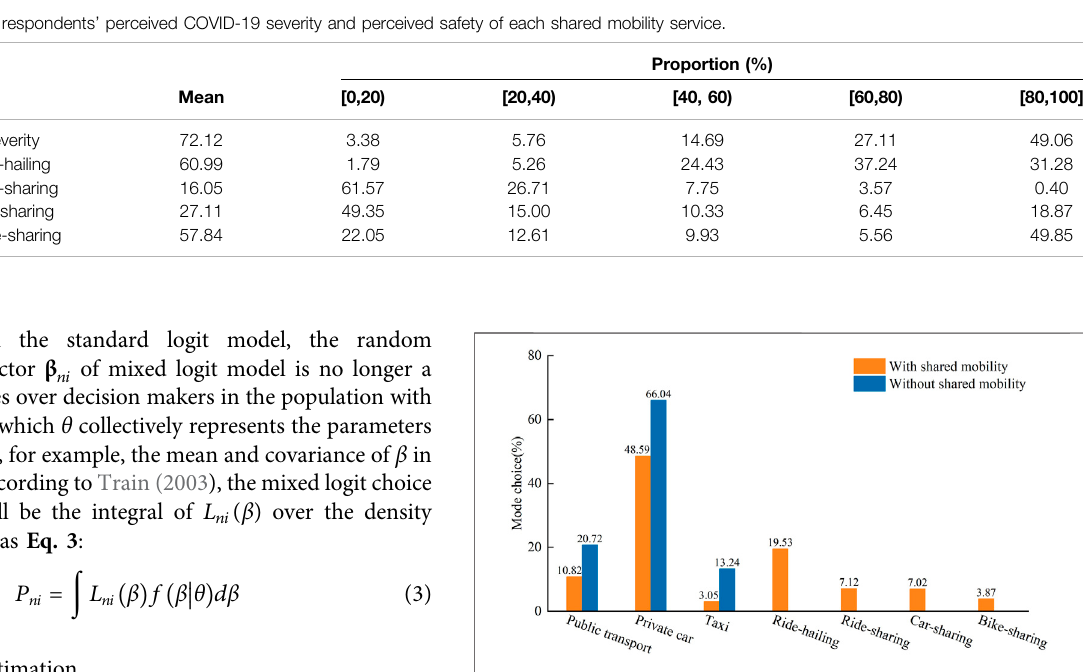
FIGURE 3 | Travel mode choices with and without shared mobility.